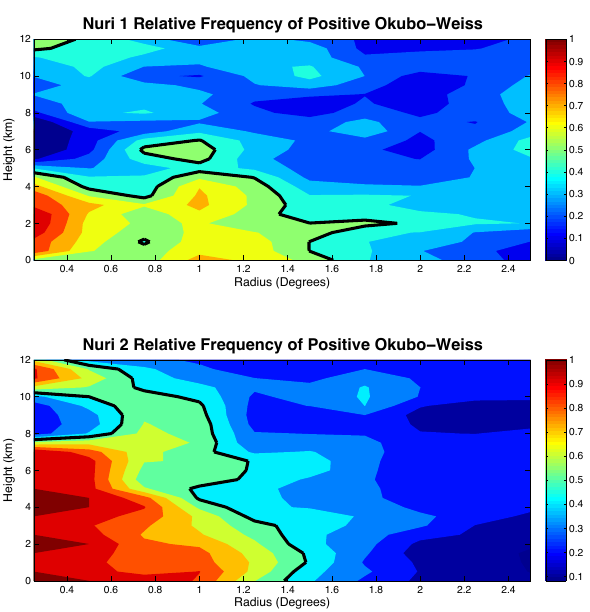
Figure 11. Two-panel vertical cross section of the frequency of pos- itive OW values. The abscissa is radial distance from the 1.5km de- rived sweet spot position in degrees and the ordinate is height (km). The thick black line represents the 0.5 contour (i.e., the location where the frequency of occurrence of positive OW is equal to the frequency of occurrence of negative OW).